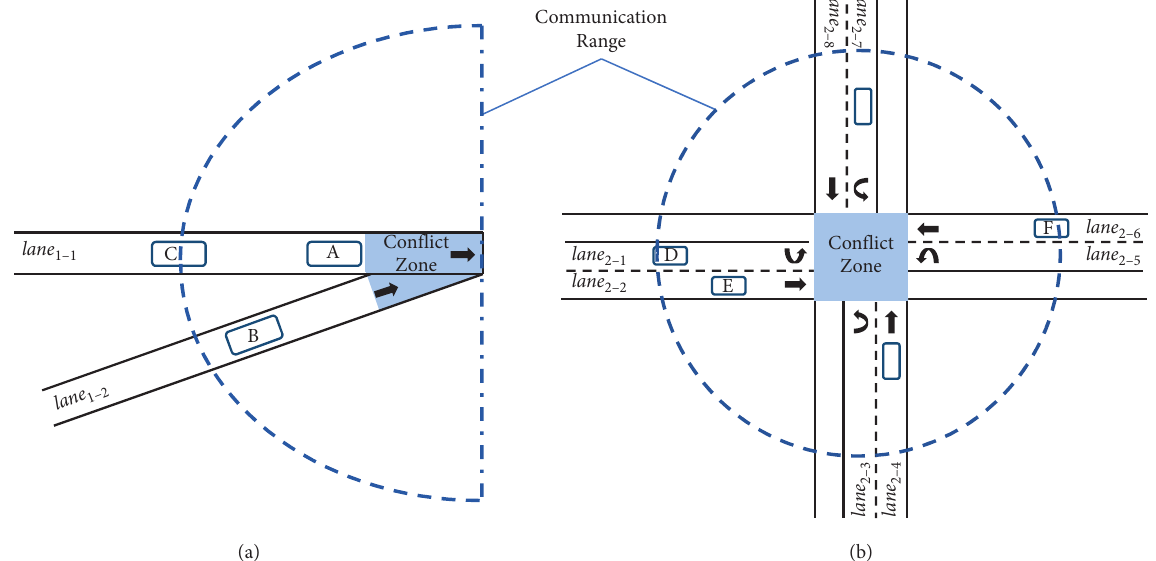
Figure 1: Two typical cooperative driving scenarios in general road networks. (a) The on-ramp in highway and (b) the unsignalized intersection in urban